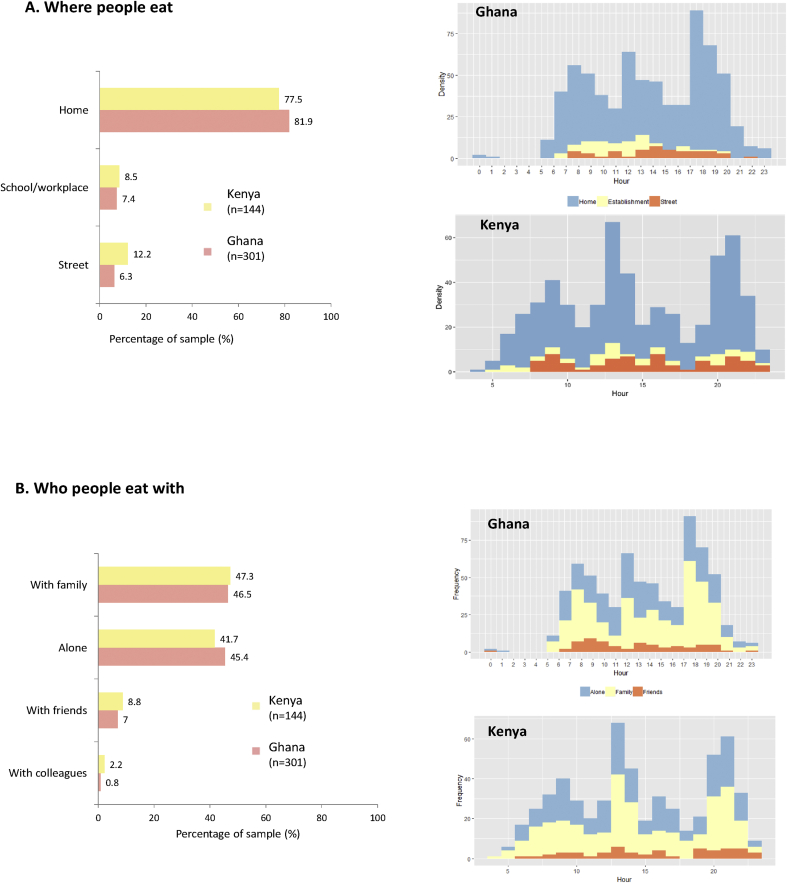
Synchronisation of eating practices incorporating where people eat (A) and with whom (B).